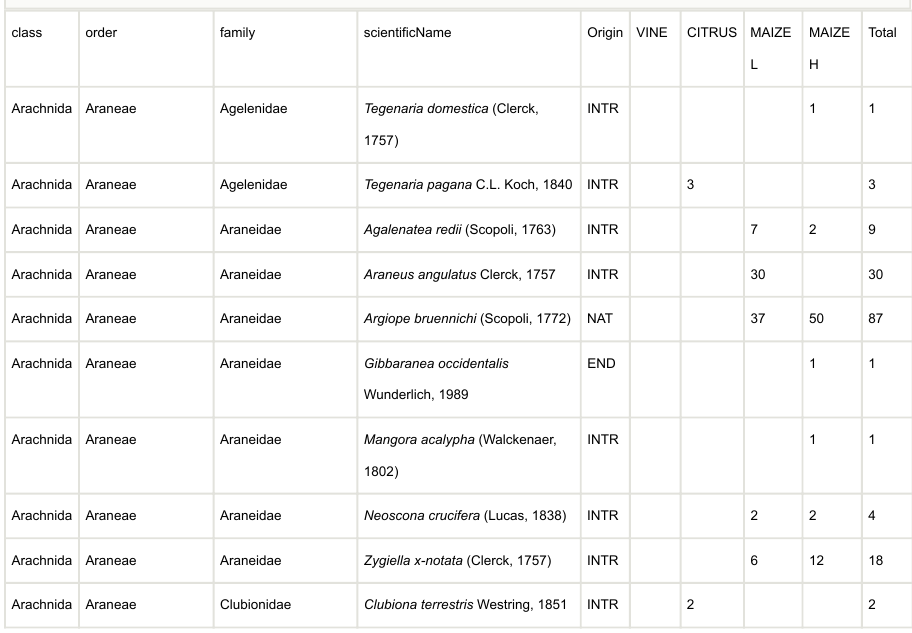
Table 2. Inventory of arthropods collected in four agroecosystems in Terceira Island (Azores, Portugal) following an elevation gradient: vineyards (Vine), citrus orchards (Citrus), maize fields at low elevation (Maize L) and at high elevation (Maize H). The list includes only the specimens identified at species-level. Class, order, family, scientific name follow alphabetical sequence. Colonisation status based on Borges et al. 2010 (Origin: END - Endemic; NAT - native non-endemic; INTR - introduced) and abundance per habitat type are provided. Bold scientific names constitute new records for Terceira Island. * - New record for